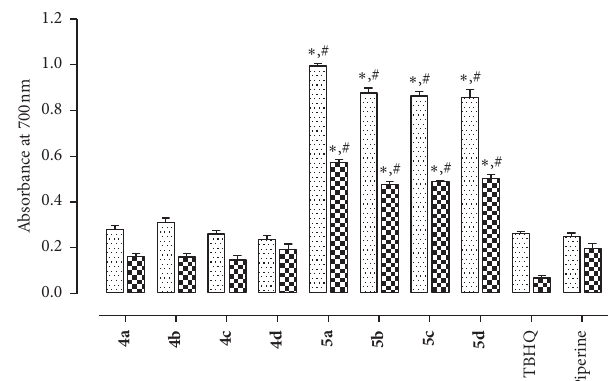
Figure 4: Measurement of total reducing ability. 80 μ M ( ); 160 μ M ( ). ∗ indicates a significant difference from the piperine group ( p < 0 . 05). # indicates a significant difference from the TBHQ group ( p < 0 .